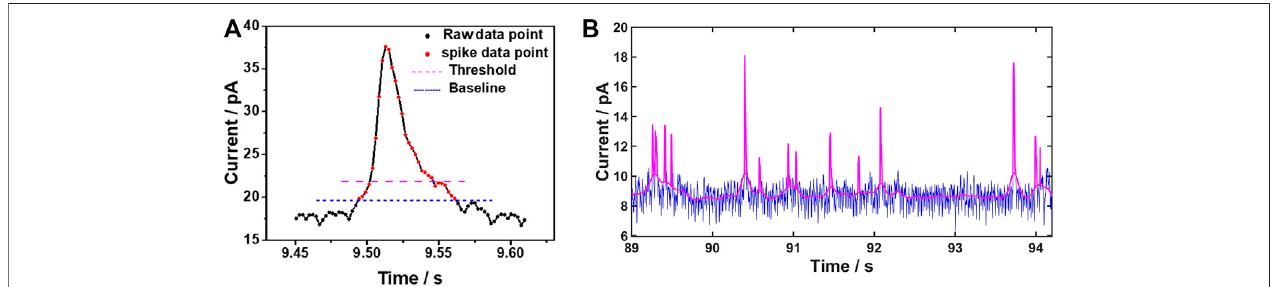
FIGURE 2 | Baseline extraction and spike identi fi cation (A) Region of an identi fi ed single current spike. The blue and pink dashed lines represent the baseline and the de fi ned threshold, respectively. The dots represent the experimental data points, with the discrete measurement points of a spike shown in red (B) Illustration of data processingoncurrent-timetraceusingMATLAB.Thebluelineistherawbackgroundnoiseandthepinklineisacombinationofbaselineandspikessignalsaftercomputation.